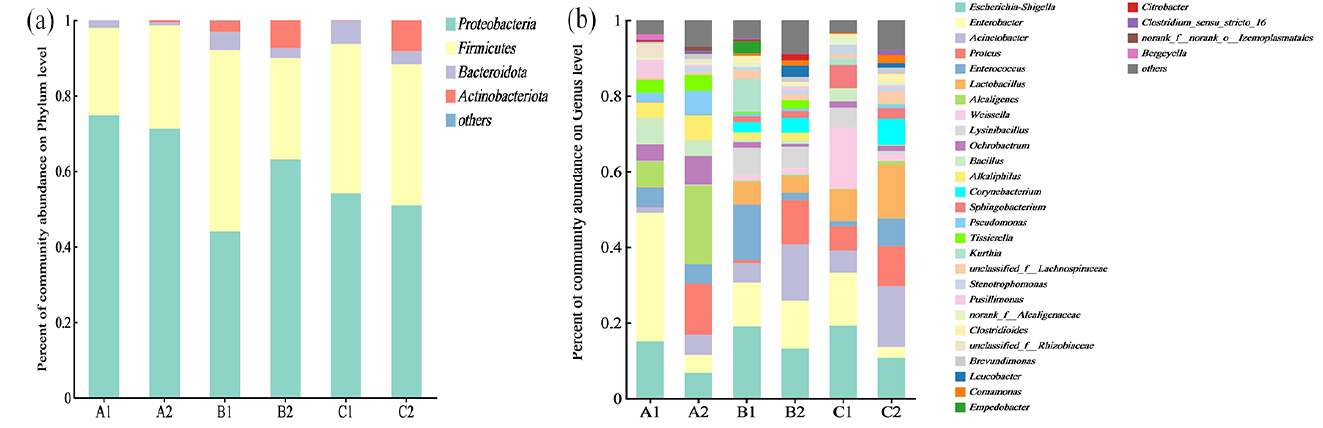
Figure 2. Composition and succession of bacteria communities during microbiological pretreatment at the ( a ) phylum level; ( b ) genus level. at the ( a ) phylum level; ( b ) genus